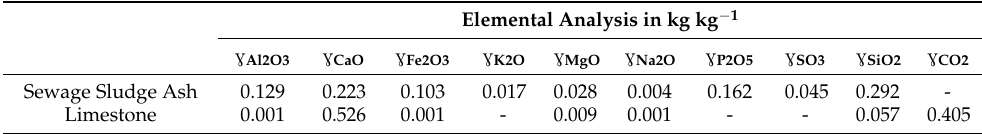
Table 2. Main elements of sewage sludge ash and